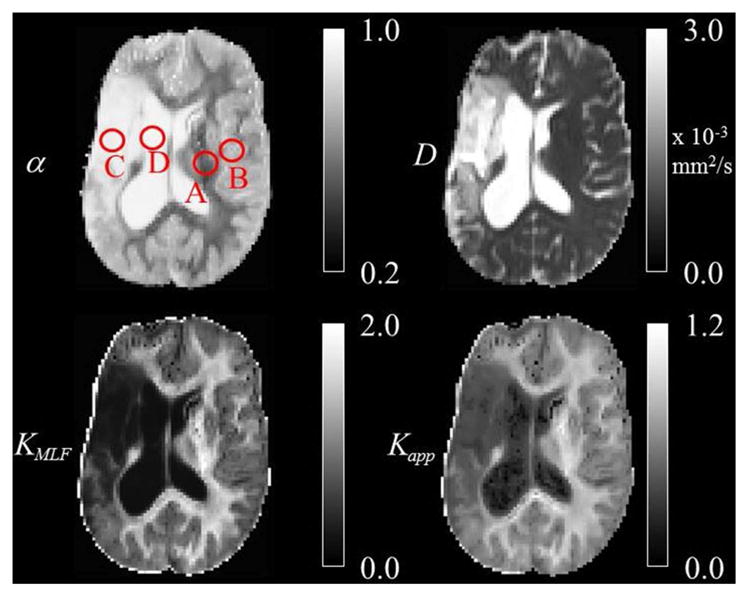
Trace parameter maps of α, D, KMLF, and Kapp for an axial slice through a brain of a chronic stroke patient with ROIs in the (A) WM, (B) GM, (C) IT, and (D) CSF.